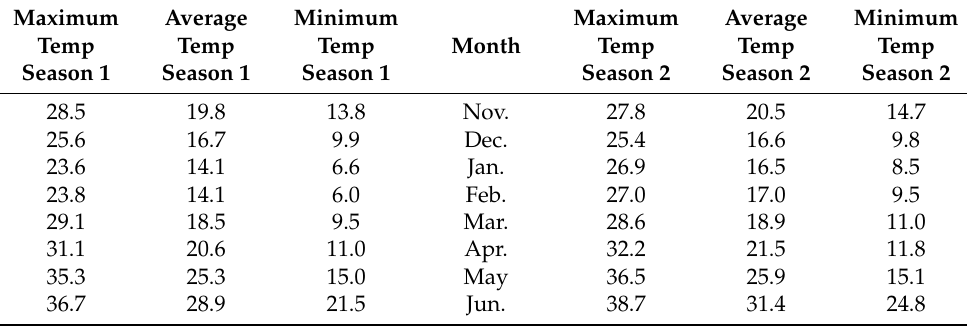
Table 7. Temperature data ( ◦ C) in Obregon, Mexico, season 1 and